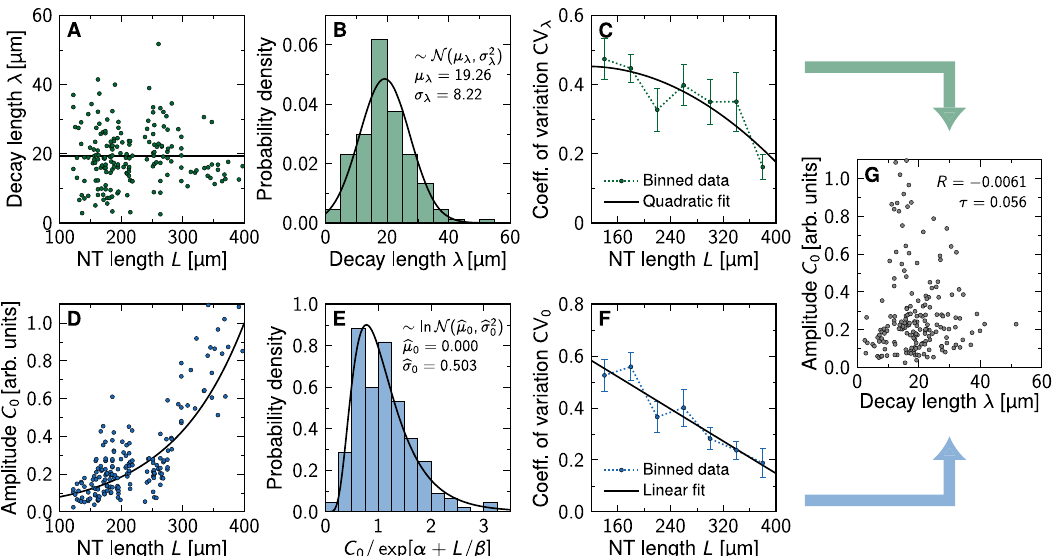
Fig. 4 Statistical properties of the SHH gradient in the developing mouse neural tube. A , B λ is constant over developmental time, consistent with a truncated normal distribution. C Binning the data into 40 μ m bins reveals that the relative variability in the data drops over time for SHH. D C 0 increases as the neural tube expands. The solid line shows an exponential fi t exp ½ α þ L = β (cid:5) . E Relative to the growing mean, the variability in the amplitude data is consistent with a log-normal distribution. F Also the relative amplitude variability of SHH declines over time. Data in ( C , F ) are presented as mean values ± bootstrapped SEM (samples per bin: n = 31, 63, 22, 36, 11, 12, 6). G SHH gradient length and amplitude are uncorrelated (Pearson ’ s correlation coef fi cient R ≈ 0, Kendall ’ s τ ≈ 0). Data points reproduced from 12 . Source data are provided as a Source Data fi